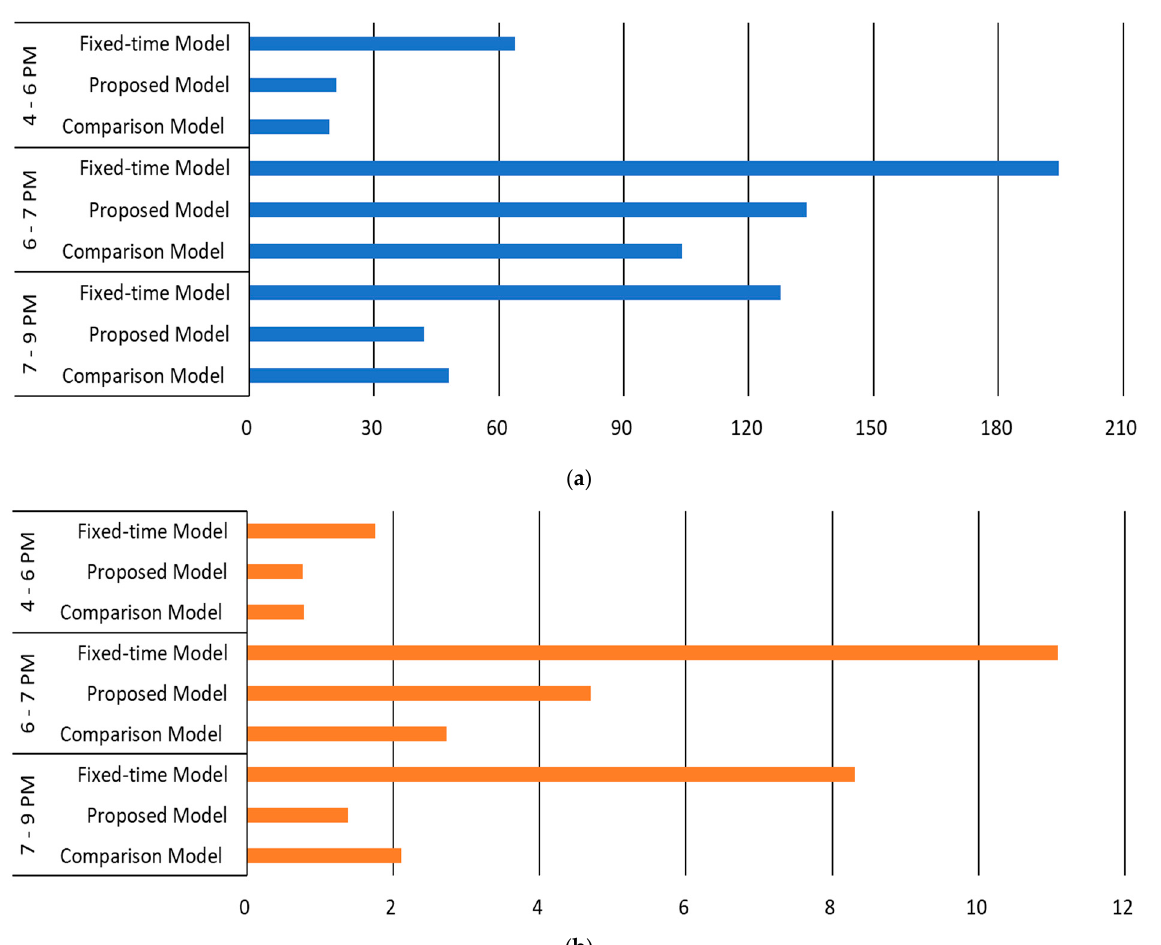
Figure 8. Measure of effectiveness: ( a ) Average delay per vehicle; ( b ) Average number of stops per vehicle.